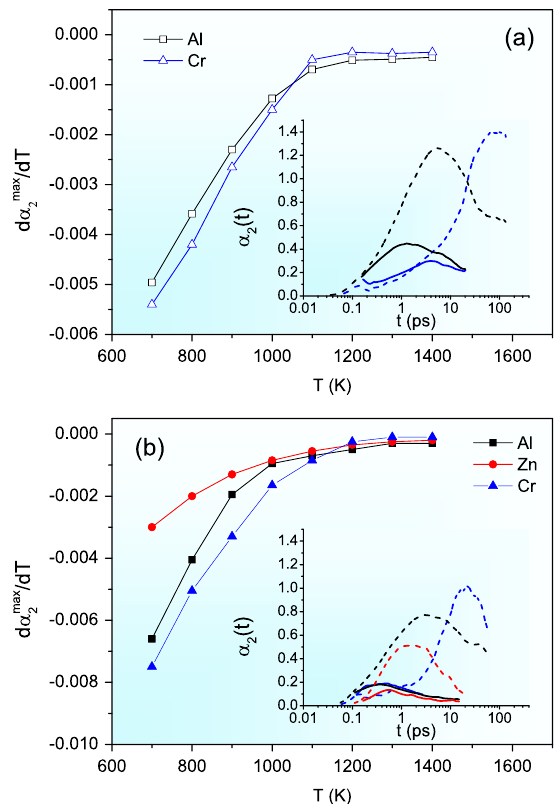
= d T for Al and Cr as a Fig. 10 a Temperature derivative d α max 2 function of temperature for Al and Cr. Inset: Non-Gaussian parameter of Al and Cr for temperatures T = 1100 and 700 K. b = d T as a function of temperature for Temperature derivative d α max 2 Al, Zn, and Cr atoms in Al − Zn − Cr ternary alloy. Inset: